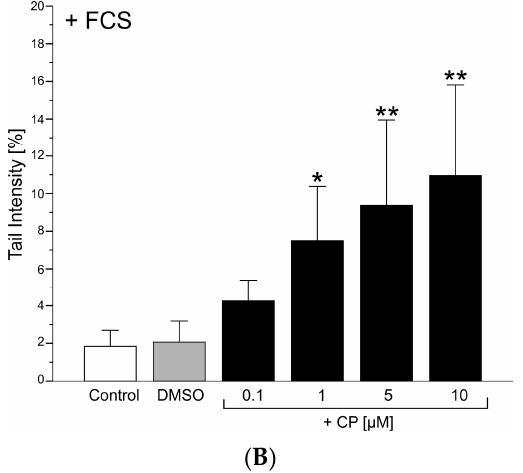
Figure 3. Effects of CPs on DNA-damage in primary cultures of rat pneumocytes; ( A ) treatment in the absence of FCS; ( B ) treatment in the presence of FCS; *: p < 0.05; **: p < 0.005 compared to the DMSO control (ANOVA, Tuckey post-hoc testing); N = 3.